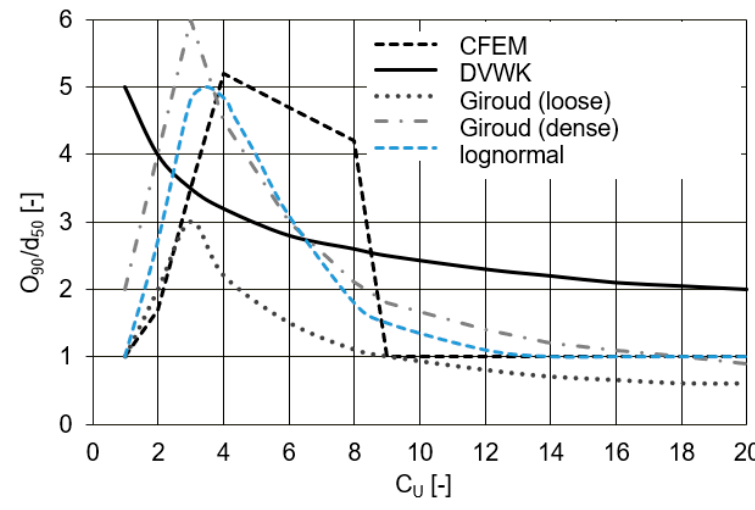
Figure 12. Comparison of retention criteria (adapted from [104]).